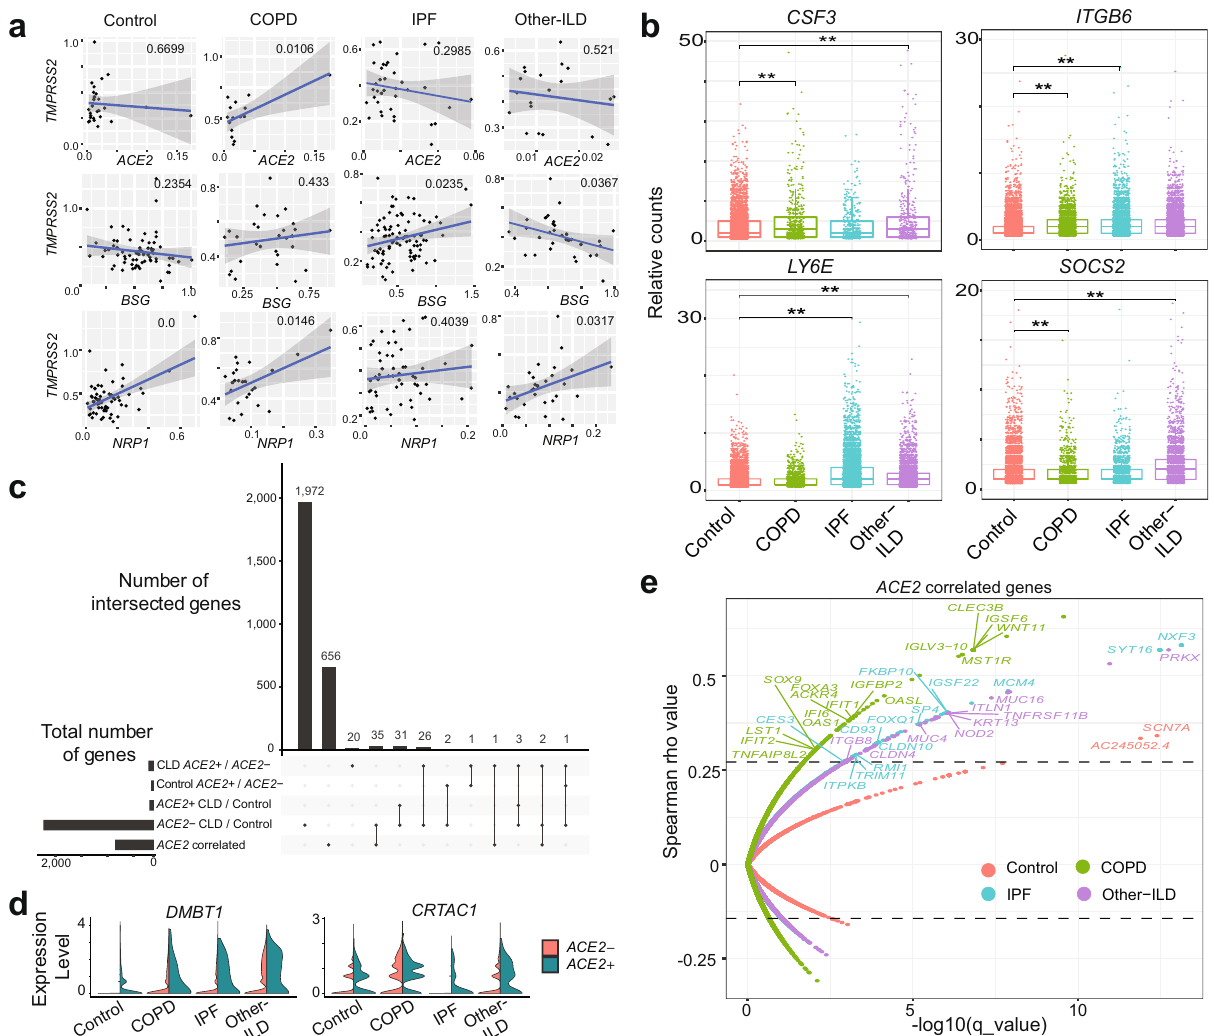
Fig. 3 CLD AT2 cells exhibit baseline differences in gene expression pro fi le coping with viral infection. a Signi fi cant gene expression correlation in AT2 cells between TMPRSS2 and ACE2 , BSG ( CD147 ) and NPR1 in COPD and IPF samples, each dot represents the average expression level of the genes of interest per sample, pairwise gene correlation analysis was done using a fi tting linear model and p value was calculated using Anova. b Boxplot shows differences in gene expression of selected SARS-CoV-2 response genes in the AT2 cell types among different diagnosis groups, Boxes: interquartile range, lower and upper hinges correspond to the fi rst and third quantiles, upper and lower whisker extends from the hinge to the largest values or smallest values of 1.5 × interquartile range; ** p value-adj ≤ 0.05 (negative binomial test, corrected for Age, Ethnicity, Smoking_status and Dataset). c Upset plot shows shared differential expression genes (DEGs) between different comparisons: ACE2 − CLD vs. Control, ACE2 + CLD vs. Control, CLD ACE2 + vs. ACE2- , Control ACE2 + vs. ACE2- and ACE2 correlated genes in the AT2 cells. d Upregulation of two genes uniquely differentially expressed in the CLD ACE2 + vs. ACE2 − . e Spearman gene correlation analysis identi fi ed genes correlated with ACE2 expression in AT2 ACE2 + cells in different diagnosis groups, p-value was adjusted using Benjamini-Hochberg corrections, dashed lines indicate the 99th percentile of Spearman rho histocompatibility complex (MHC) class II genes (HLA type II genes) (Fig. 4b). HLA type II gene module score increased across all disease groups but especially in the Other-ILD samples, compared to controls (Fig. 4d). Type I IFN response (IFNa score) is slightly elevated in the diseased macrophages and pDCs (Supplementary Fig. 11a). IL6-associated tocilizumab responsive genes (IL6 score) are expressed at a higher level in the disease groups IPF and Other-ILD, but lower in the COPD samples (Supplementary Fig. 11b). Previous studies demonstrated elevated exhaustion levels in CD8 T cells in severely affected COVID-19 patients 62,63 . All CLD T cells have higher expression levels of cytotoxicity and exhaustion genes compared to controls (Fig. 4e, f). These perturbations in the T Cell population of CLD lungs may diminish the host immune response to viral infection,